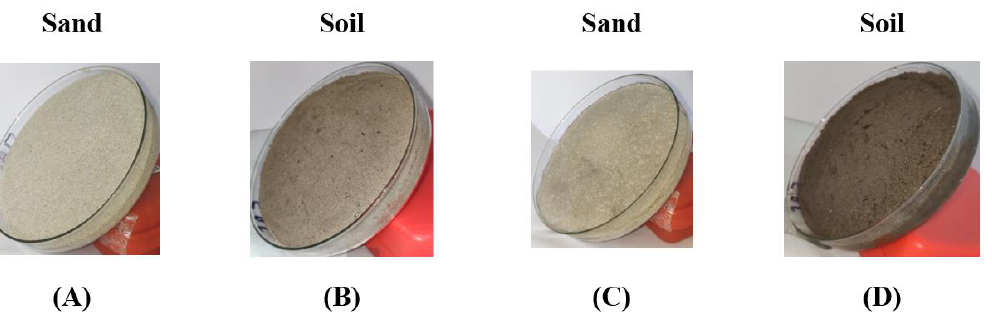
Figure 6. Sand ( A ) and soil ( B ) treated with ACP# hydrogel after exposure to wind at a speed of 76 km/h. Sand ( C ) and soil ( D ), both with deposited ACP# hydrogel, after treatment with water.